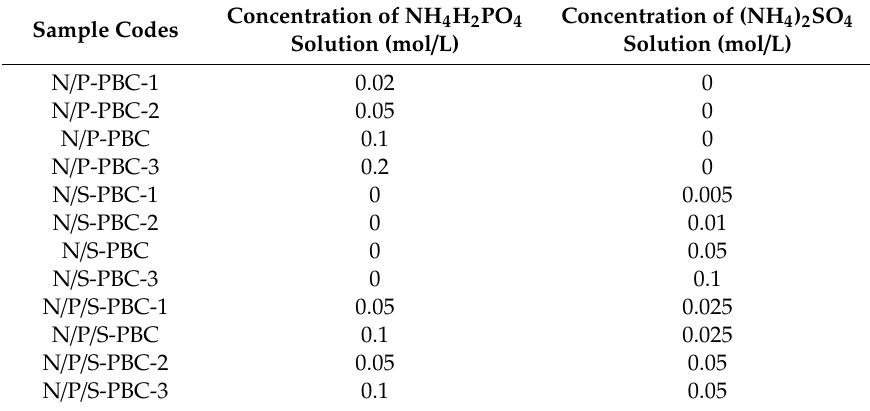
Table 1. The designation of samples prepared in this